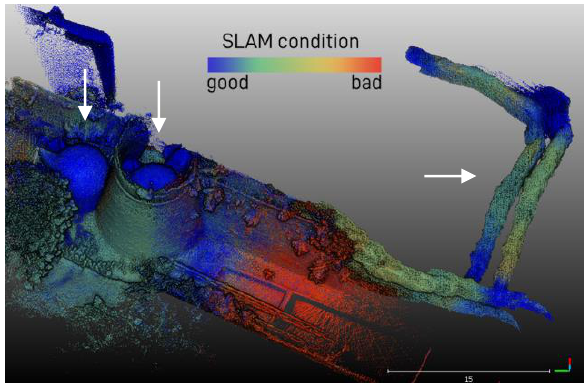
Figure 4. Example of a trajectory alignment drift